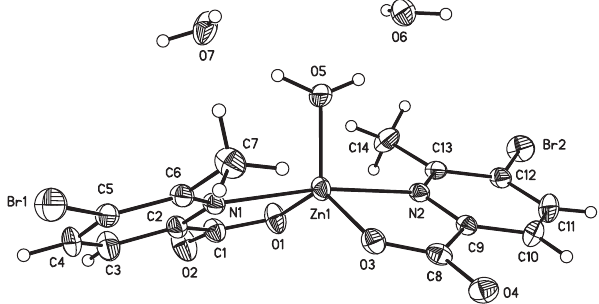
Table 1: Data collection and